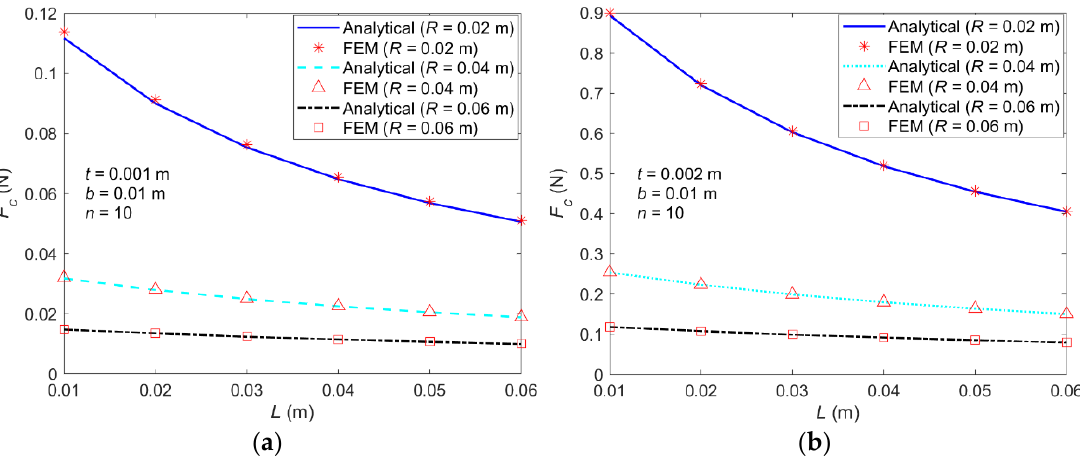
Figure 3. Parametric study of corrugation unit shape: ( a ) F c vs. L when t = 0.001 m and R = 0.02, 0.04 and 0.06 m; ( b ) F c vs. L when t = 0.002 m and R = 0.02, 0.04 and 0.06 m.